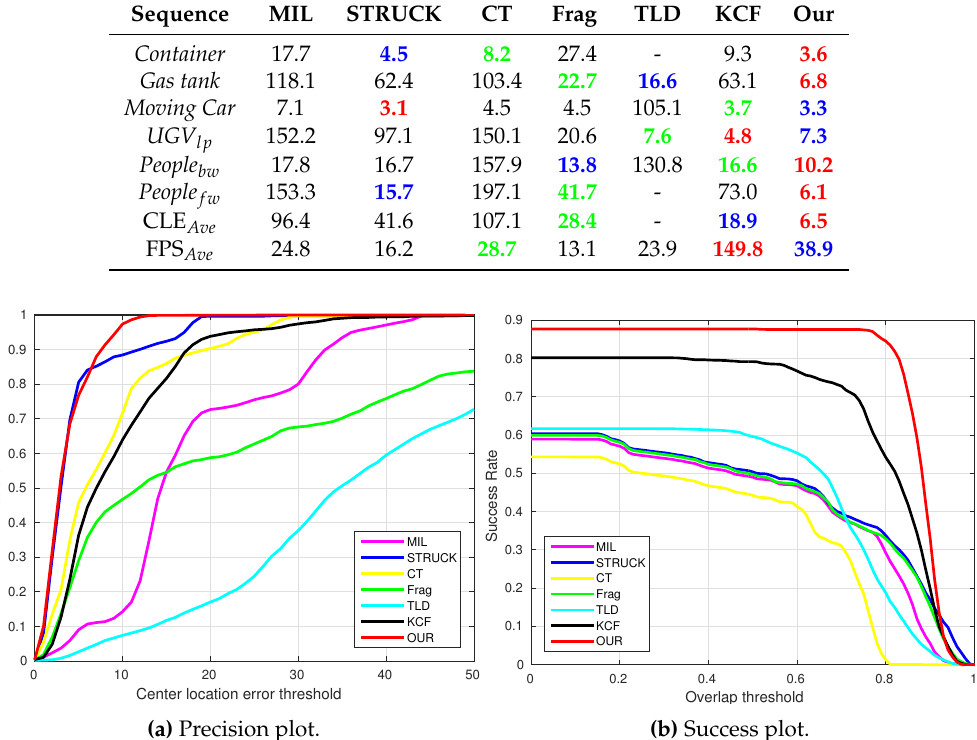
(a) Precision plot. (b) Success plot. Figure 12. Precision and success plots of all visual trackers with the container image